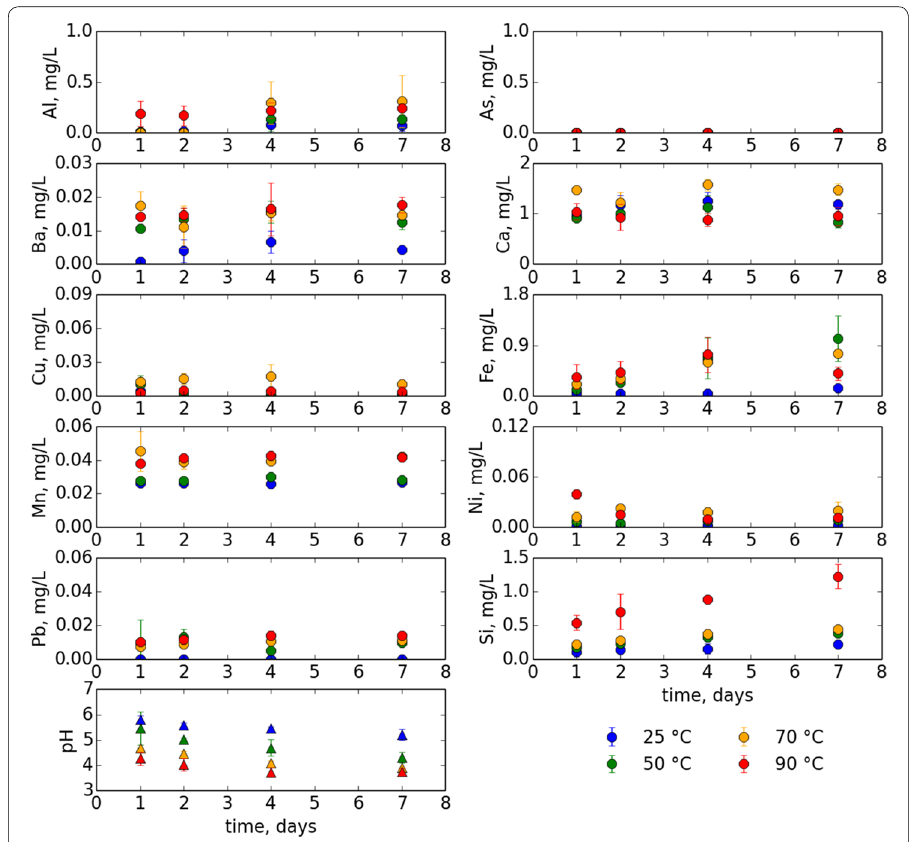
Fig. 2 Extracted elemental concentrations and changes of pH over time observed in the leaching of the Het- tangian sandstone under oxic